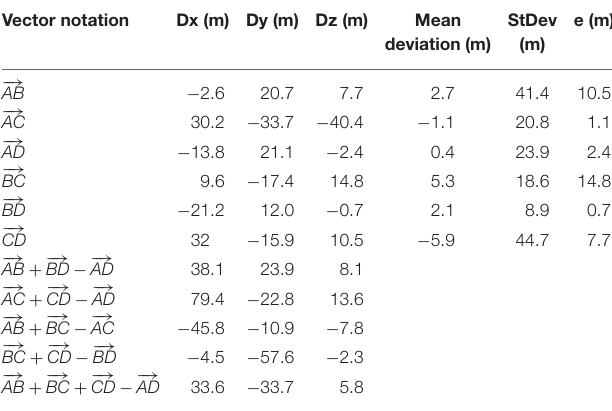
TABLE 2 | The co-registration shifts between the different DEMs that was necessary before DEM differencing. Vector